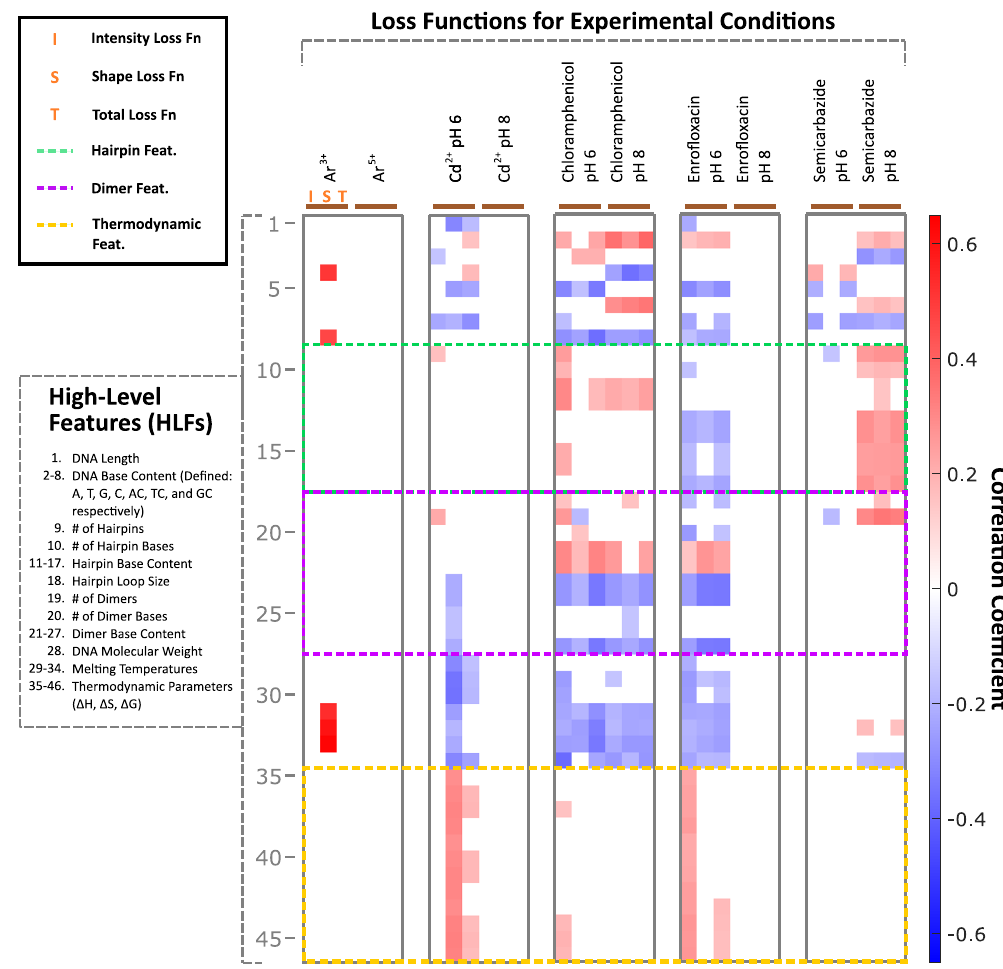
Fig. 3 HLF Correlation with Sensor Response Function for Each Experimental Condition. A color map is shown for the Pearson correlation coef fi cients ( p value < 0.05) between each HLF based on experimental DNA sequences and sensor response function (Eq. (1)) that describes photophysical changes with analyte addition (red denotes positive correlation and blue with negative correlation). Sensor responses are further delineated as intensity, shape or total sensor response function for each experimental condition. Sections representing unique HLF groups are highlighted. Additional details for each individual HLF can be found in the Supplemental